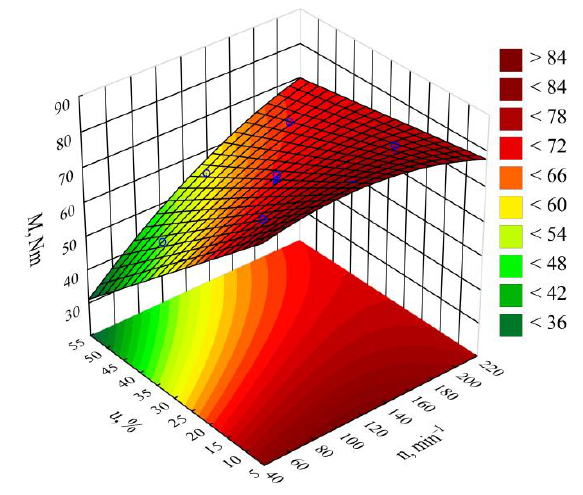
Figure 5. Response surface graph for the screw drive torque M versus the screw rotational speed n and bran mass fraction u.